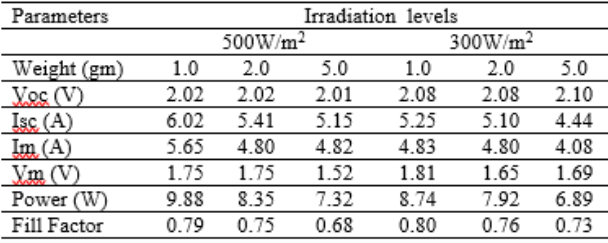
Figure 15. I-V and P-V characteristics of Brick furnace dust with reflector at irradiation 300W/m 2 Using the above results, the FF, power and electrical parameters of the PV module used are calculated. The FF obtained at different weights and irradiation are shown in Table 6 and as Table 6. Comparison of parameter with Brick furnace dust at 500/300 W/m